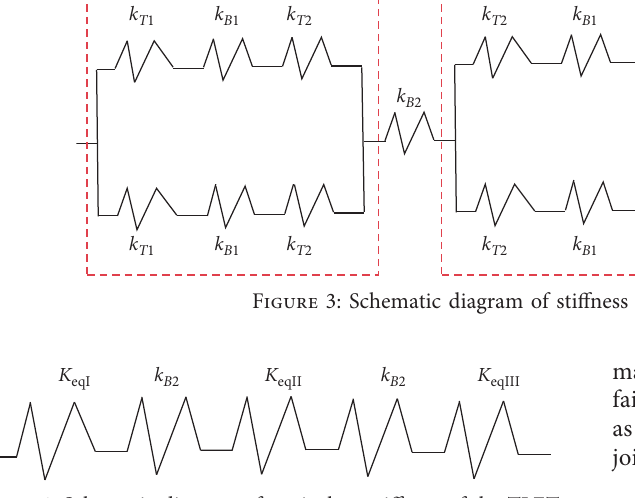
Figure 4: Schematic diagram of equivalent stiffness of the TLET- type flexure